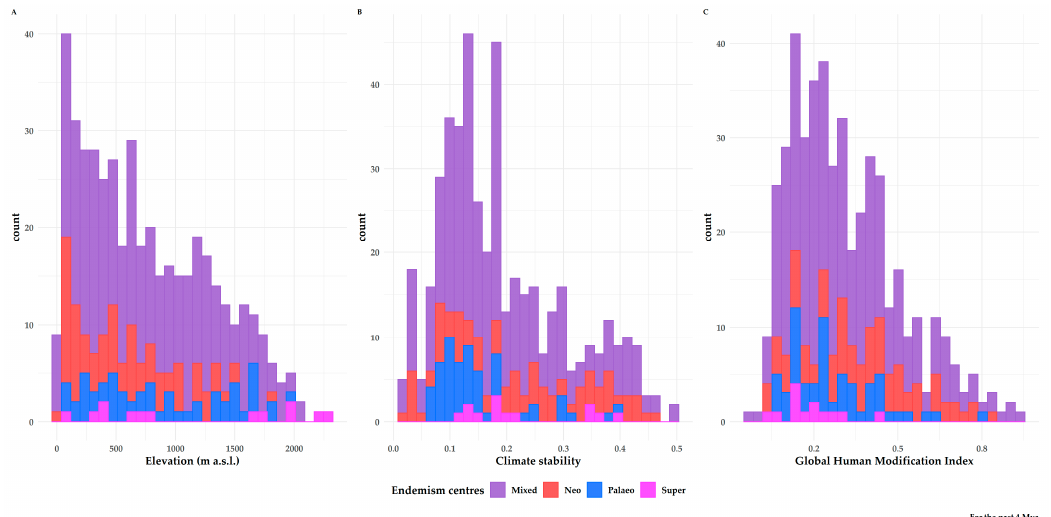
Figure 9. From left to right: ( A ) Altitudinal distribution, ( B ) Climate stability values and ( C ) Global Human Modification index values of the different types of endemism centres identified by the CANAPE analysis in Greece.